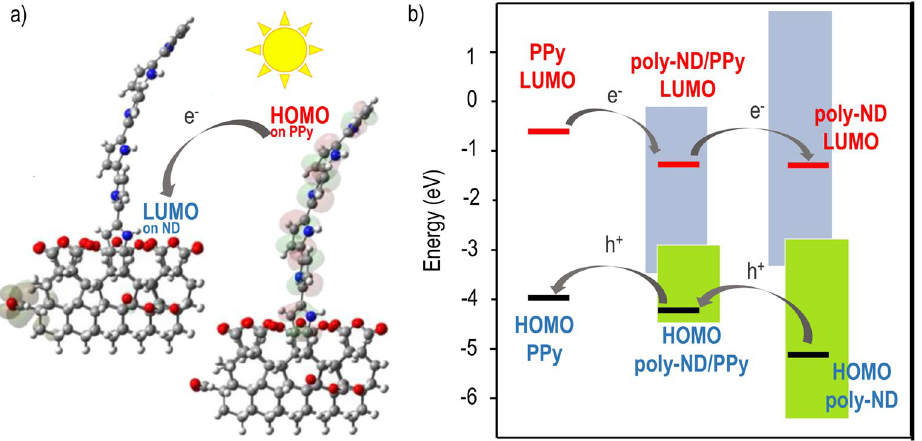
Figure 7. ( a ) Example of spatial separation of PPy HOMO and ND LUMO. Based on DFT calculations. ( b ) Scheme of HOMO and LUMO energetic levels composite of separate materials and their interface with the most probable charge transfer due to level